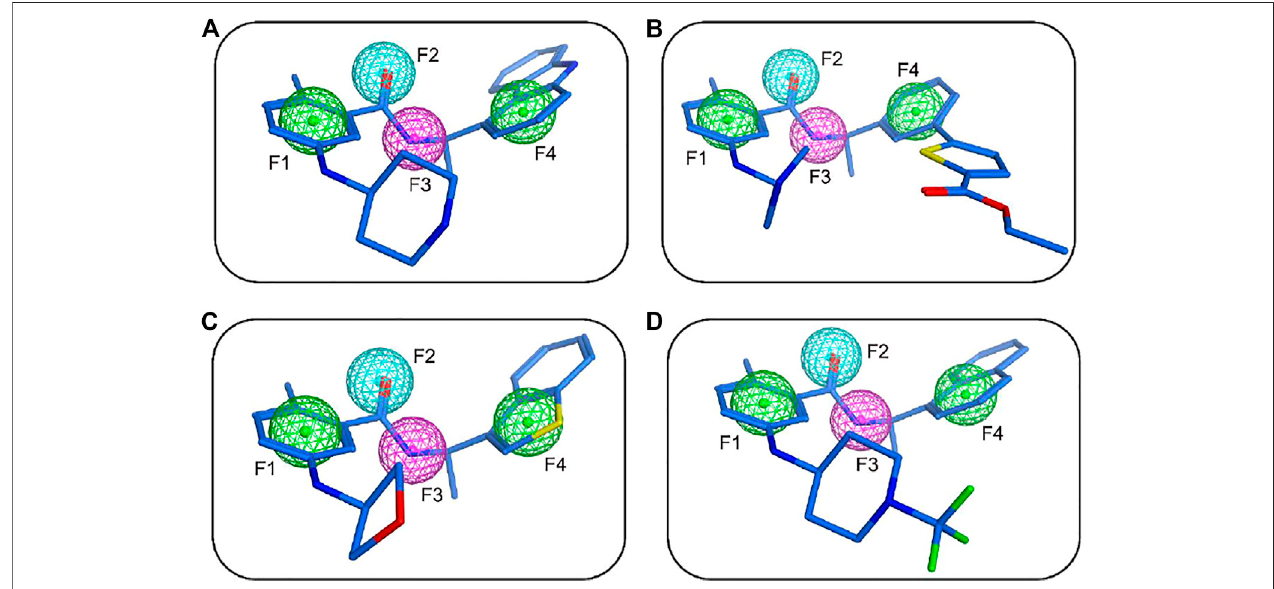
FIGURE3| ThemappingofthePLpro-modelwithhit1 (A) ,hit2 (B) ,hit3 (C) ,andhit4 (D) .Hitsaredepictedasbluestickform.Pharmacophorefeaturesarecolor- coded: green, two aromatic features (F1 and F4); cyan, one hydrogen-bond acceptor feature (F2); purple, one hydrogen-bond donor feature (F3).